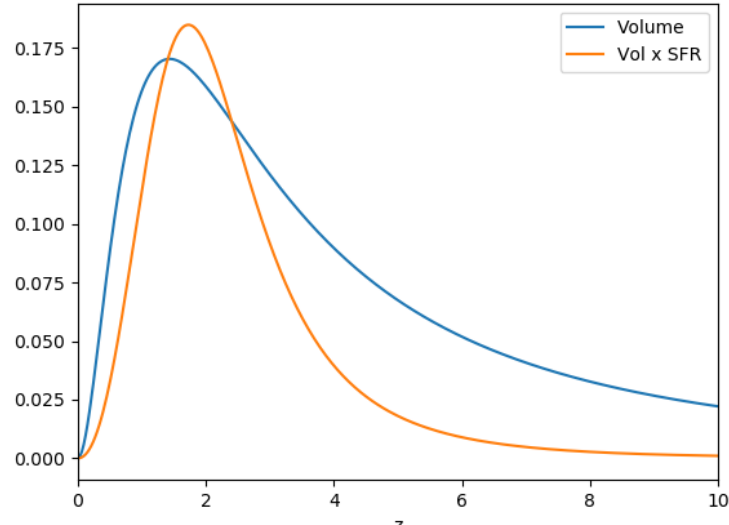
Figure 21. Bare volume factor with respect to redshift (blue) and volume factor times the realistic star formation rate of Madau and Dickinson